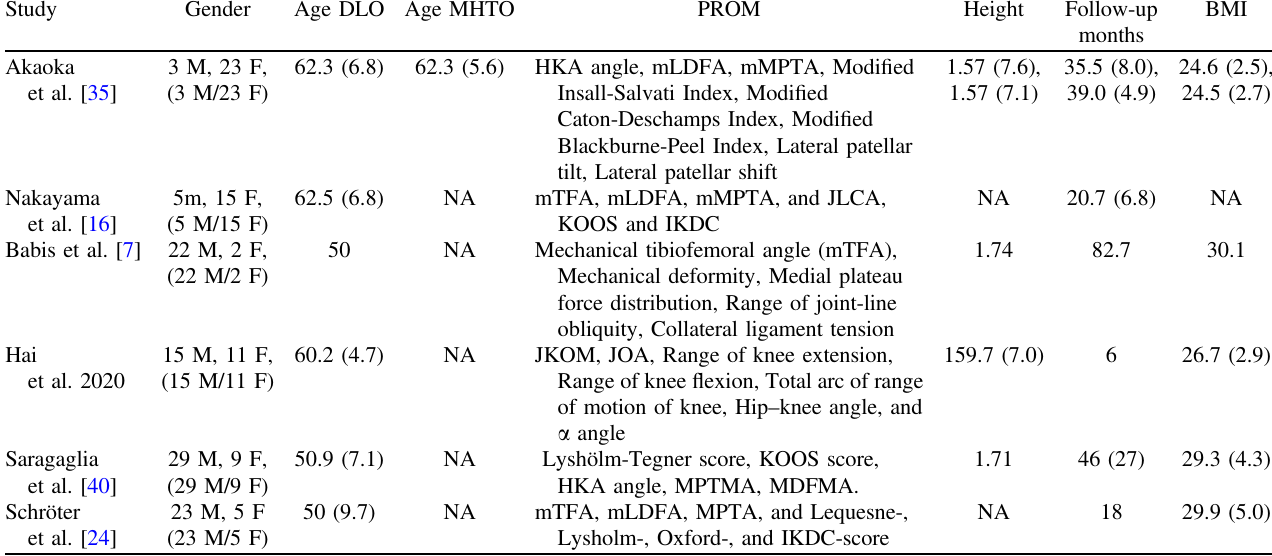
Table 2. Patient